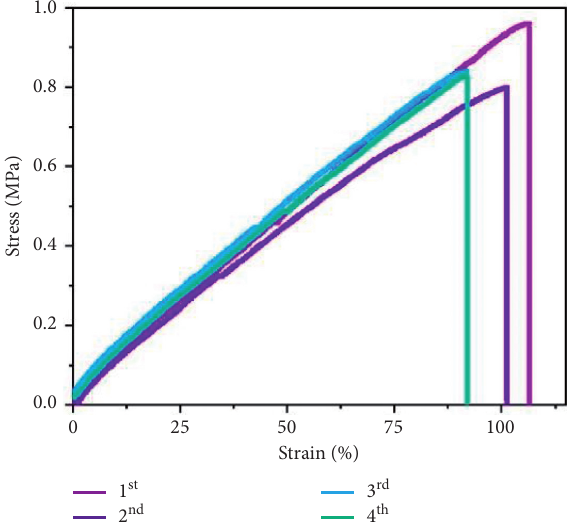
Figure 10: Stress-strain curve of the sealing films.